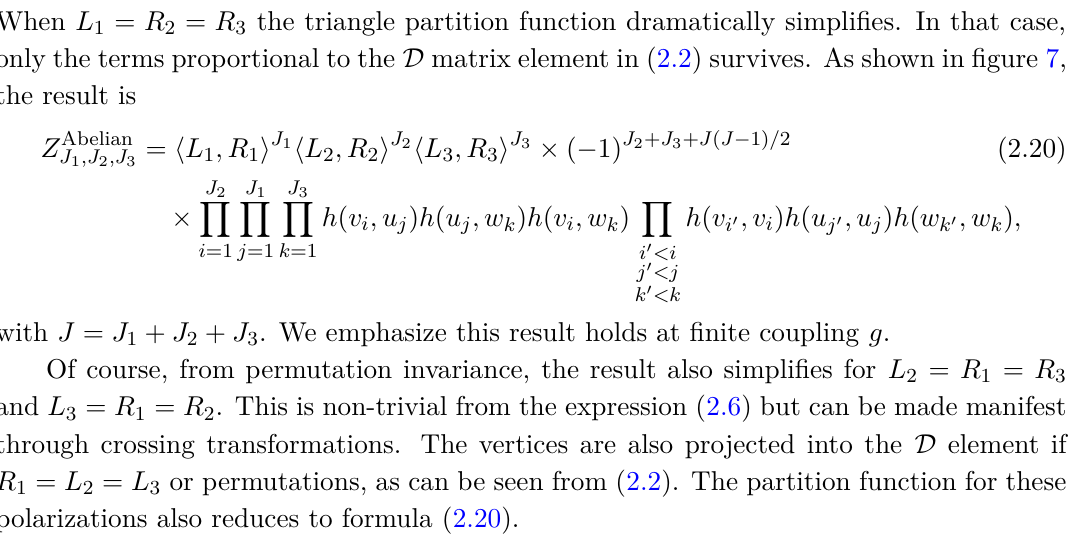
a L b S cd c L d h ( v ( u ) = − R ) . This simplification 2 1 i , u i +1 2 1 2 , u 1 ab = R = R , the partition function reducing to the product of abelian 1 2 3 = L = L 1 2 3